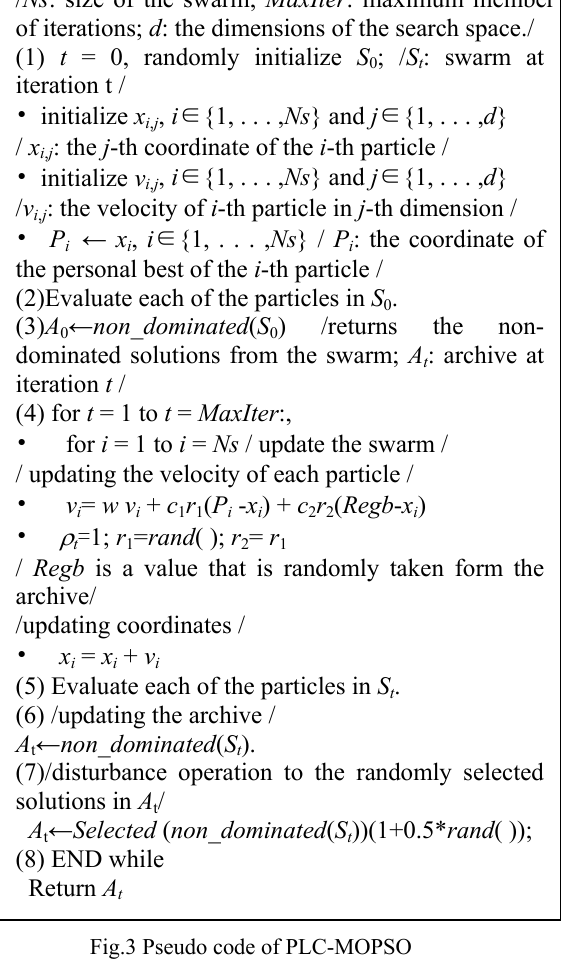
Table 2 Definition of the MOO problems